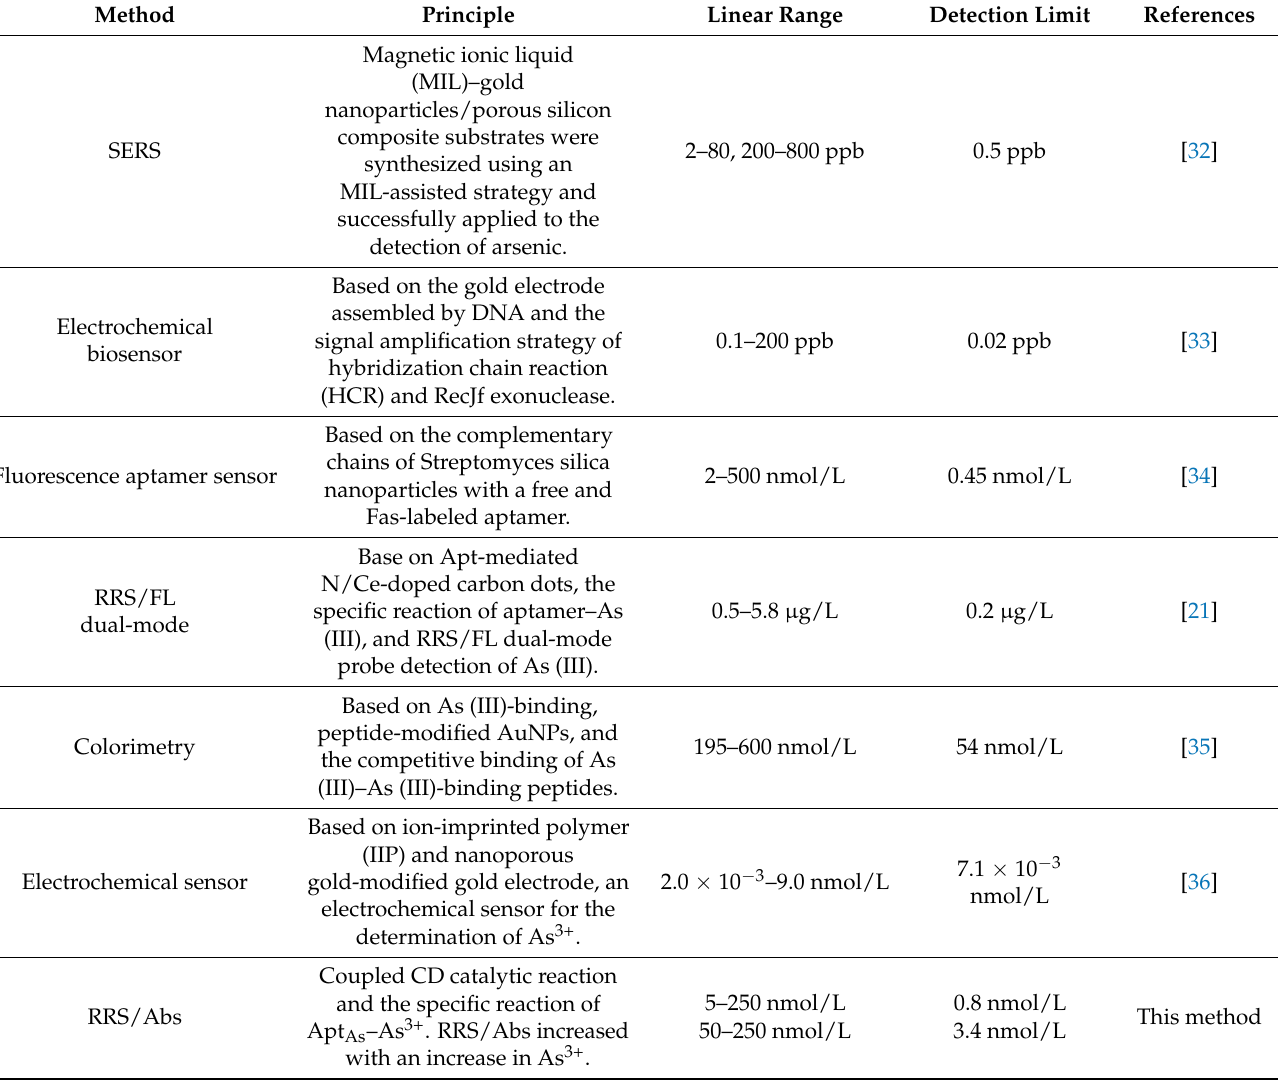
Table 2. Comparison of some reported spectral methods for As 3+ .